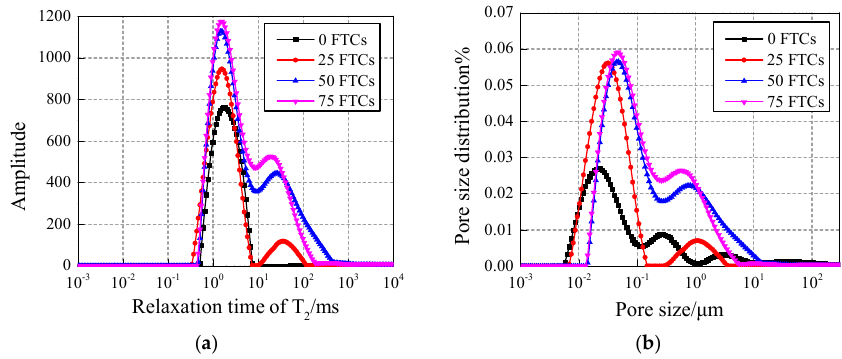
Figure 11. ( a ) T 2 spectrum and ( b ) pore fluid size distribution of 30 nm-NT added concrete. (2) Direct comparison of NS and NT added concrete with different contents of nano-particle addition.